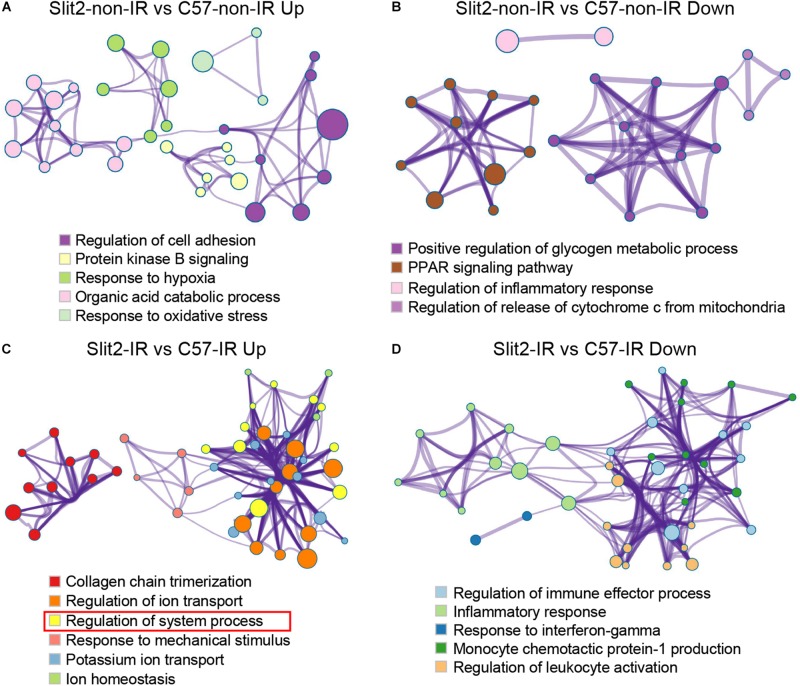
Gene set enrichment analysis of differentially expressed genes (DEGs). Shown are the results for the upregulated DEGs in the Slit2-non-IR vs. C57-non-IR comparison (A), the downregulated DEGs in the Slit2-non-IR vs. C57-non-IR comparison (B), the upregulated DEGs in the Slit2-IR vs. C57-IR comparison (the rectangles in red indicate gene sets enriched for muscle contraction, regulation of heart rate, regulation of heart contraction, heart contraction, actin-mediated cell contraction, regulation of blood circulation, and adrenergic signaling in cardiomyocytes) (C), and the downregulated DEGs in the Slit2-IR vs. C57-IR comparison (D). In the Metascape protein interaction network, two or more gene sets enriched for biological processes/KEGG pathways/Reactome pathways with similar functions were clustered. Within each cluster, the gene set with the highest enrichment score (log P-value) was used to annotate the cluster. The links between the clusters are shown. The cluster annotations are color-coded. The size of a node (representing an enriched gene set) is proportional to the number of DEGs in the set, and the width of an edge is proportional to the number of genes shared between the two enriched sets.